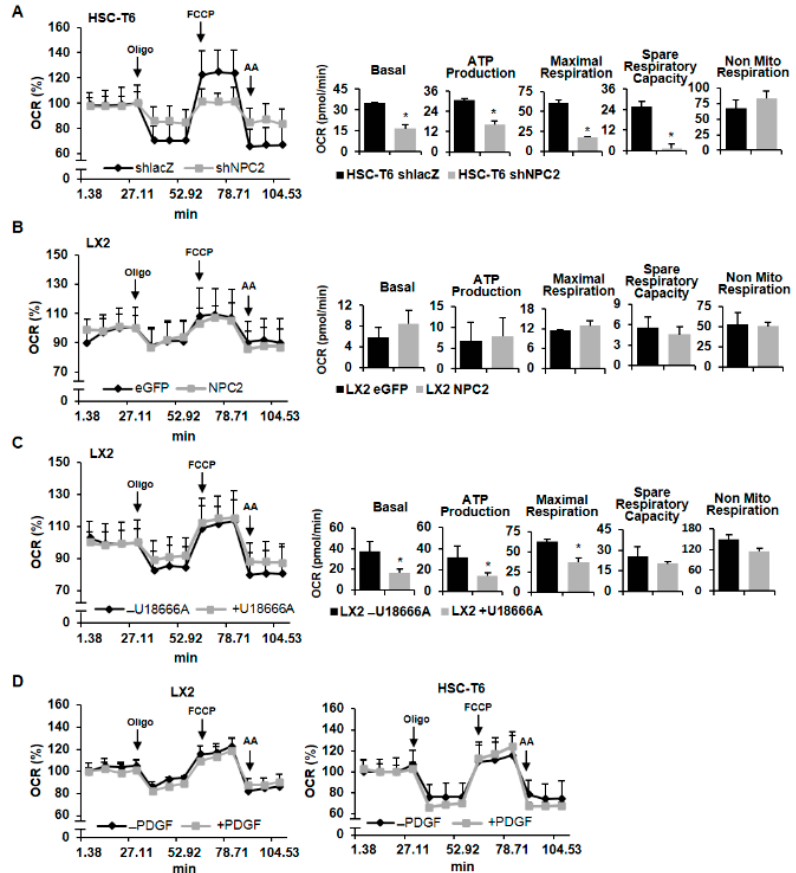
Figure 4. Downregulating NPC2 expression and accumulating free cholesterol in HSCs caused mitochondrial function disruption. ( A , B ) Mitochondrial respiration functions of NPC2-downregulated and -overexpressed cells were analyzed by a Seahorse XFe extracellular flux analyzer. A quantity of 1 µM oligomycin, 2 µM FCCP, and 0.5 µM rotenene/antimycin A was injected into the well at the 4th, 8th, and 11th time point. Quantitative data are shown in the right panel. ( C ) LX2 cells were pretreated with or without 1 µM U18666A for 24 h, and the oxygen consumption rate was analyzed by a Seahorse XFe extracellular flux analyzer. ( D ) LX2 and HSC-T6 cells were pretreated with or without 10 ng/mL PDGF-BB overnight and then subjected to the Seahorse XFe extracellular flux analyzer to analyze the mitochondrial respiration functions. Data are shown as mean ± SD. * p < 0.05 vs. black bar.